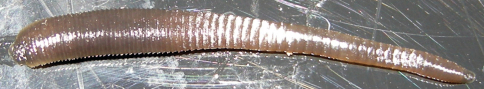

Orobdella koikei sp. n., paratype, KUZ Z186, taken of live animal, dorsal view.